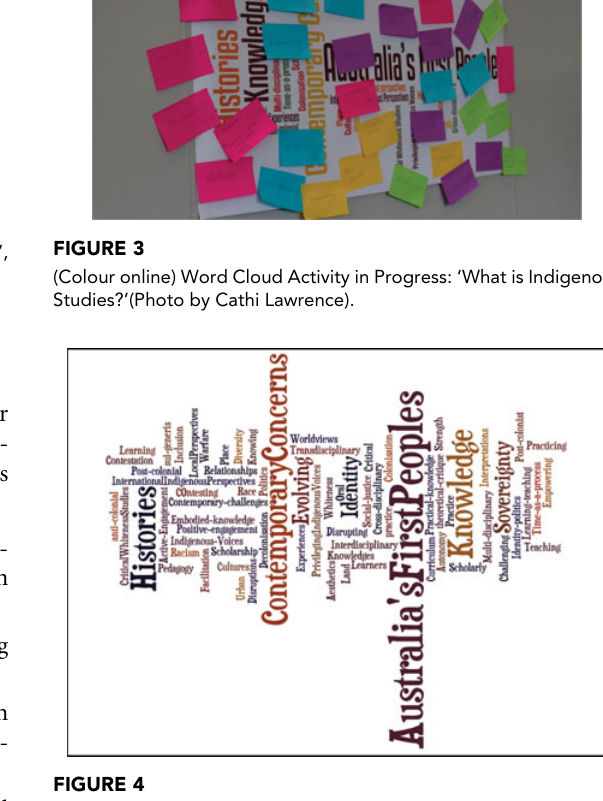
(Colour online) Revised Word Cloud, October 25,